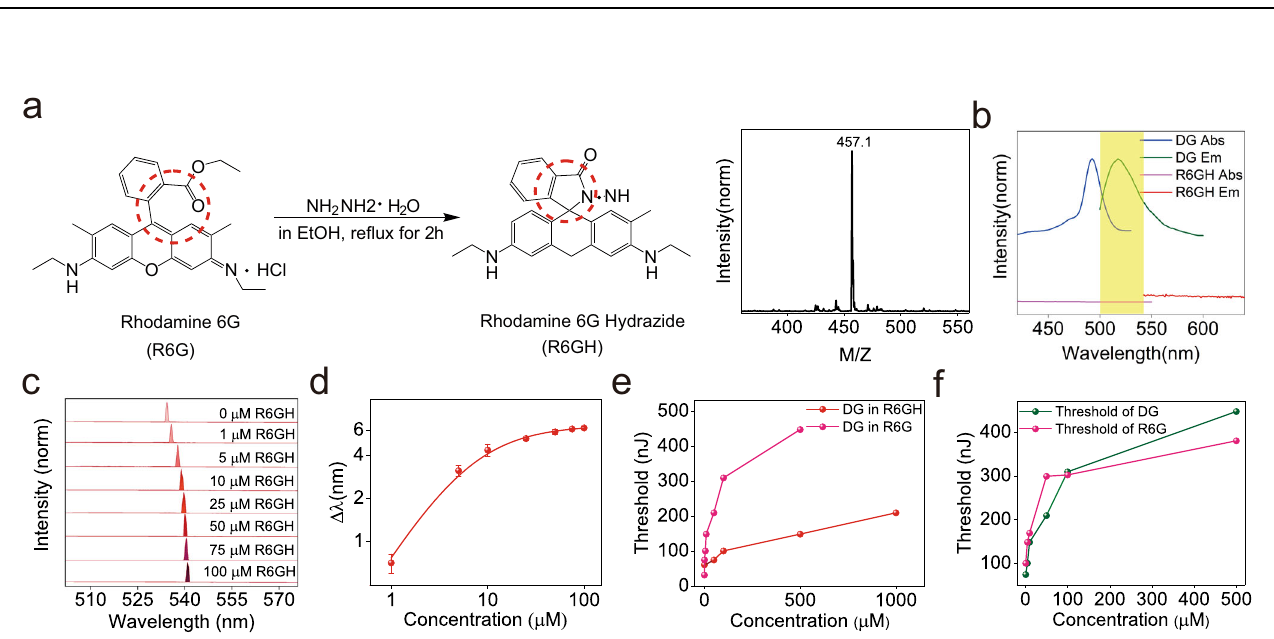
values±SD( n =5). c log-scale Δλ -concentrationcurveshowingthatthewavelength gap ( Δλ ) exponentially increases as the R6G concentration increases (for a math- ematical model ref. SI table S3, Δλ = λ 2(R6G) - λ 1(DG) ). Data are presented as mean values±SD ( n